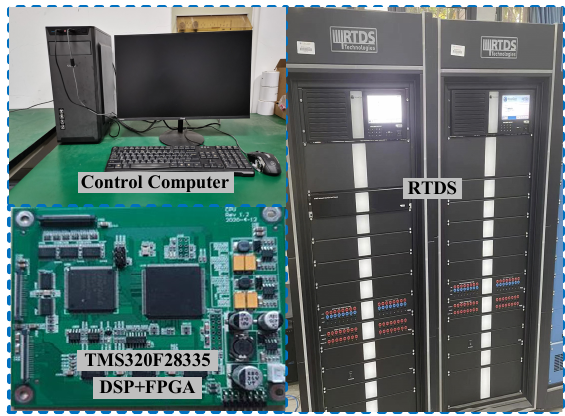
Figure 24. Experimental platform of LCL-TFSCI .